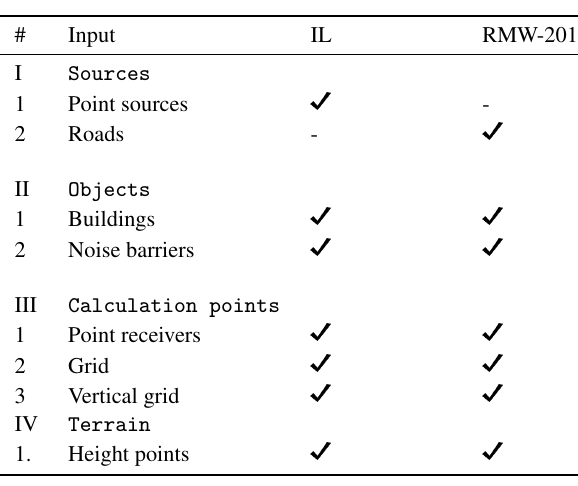
Table 2: Inputs for industrial and road traffic noise Case of Road traffic noise